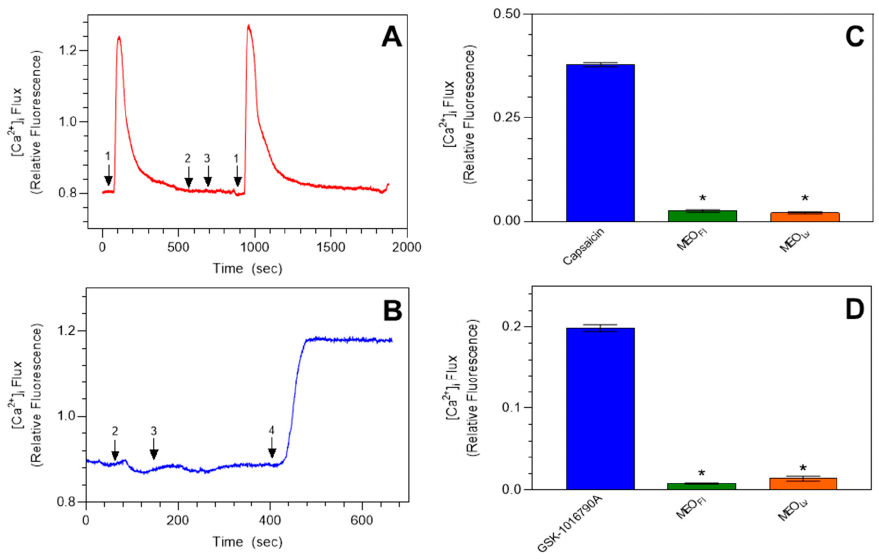
Figure 3. Monarda essential oil-induced increases in [Ca 2 + ] i are independent of TRPV1 and TRPV4 channels. Representative traces demonstrating the unaltered [Ca 2 + ] i baseline in HEK hTRPV1 ( A ) and HEK hTRPV4 ( B ) in the presence of MEO Fl (arrow #2) and MEO Lv (#3) (25 µg/mL). The TRPV1 agonist capsaicin (100 nM, #1) and the TRPV4 agonist GSK-1016790A (10 µM, #4) were used to confirm the expression of functional TRPV1 and TRPV4 channels in HEK cells. Summarized data are shown in ( C ) and ( D ), respectively. The data are expressed as the change in [Ca 2+ ] i influx from baseline to peak [Ca 2+ ] i and plotted as the mean ± SEM. * p < 0.0001 compared to the agonist-induced [Ca 2+ ] i influx. Statistical analysis was performed using one-way analysis of variance; n = 90 cells from 3 independent experiments.